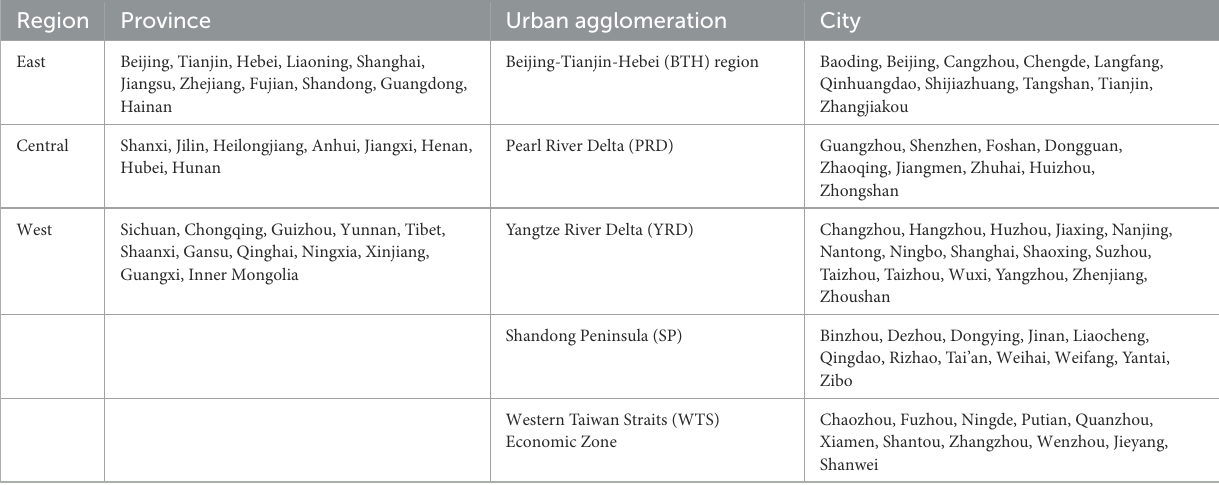
TABLE 1 Description of the correspondence of the study subjects.